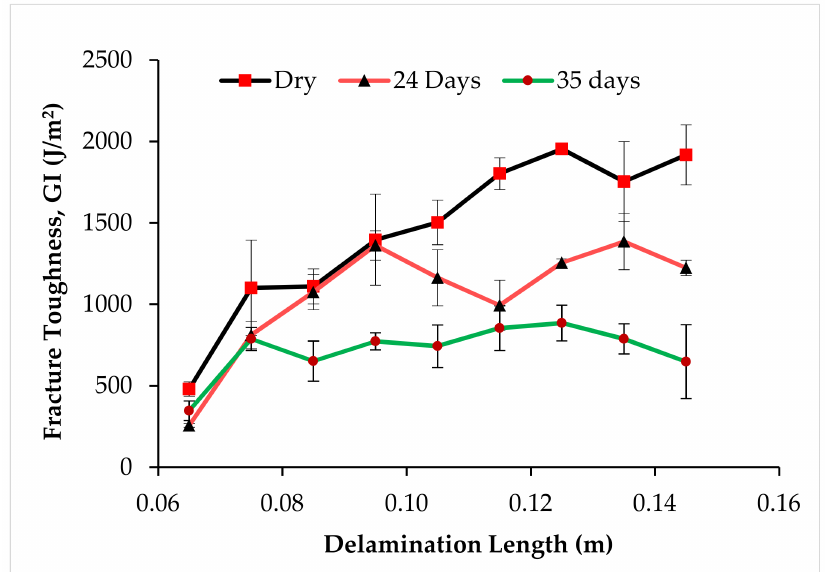
Figure 5. Crack growth curve.